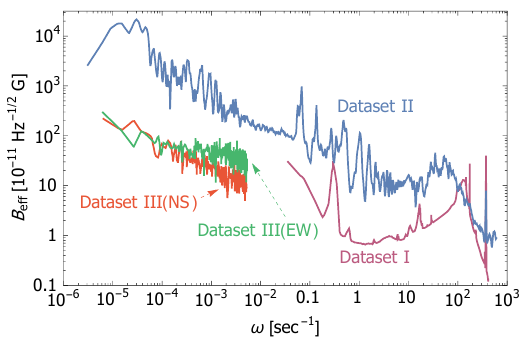
Figure 2 . The spectral noise density as a function of the angular frequency collected from three experiments and used to derive the limits in this work. Dataset I (purple) is taken from (cid:12)gure 5.3 of ref. [47], dataset II (blue) is taken from (cid:12)gure 4.17 of ref. [48], and dataset III (orange and green) are taken from (cid:12)gure 5.11 of ref. [49]. Note that we present the data as a function of the